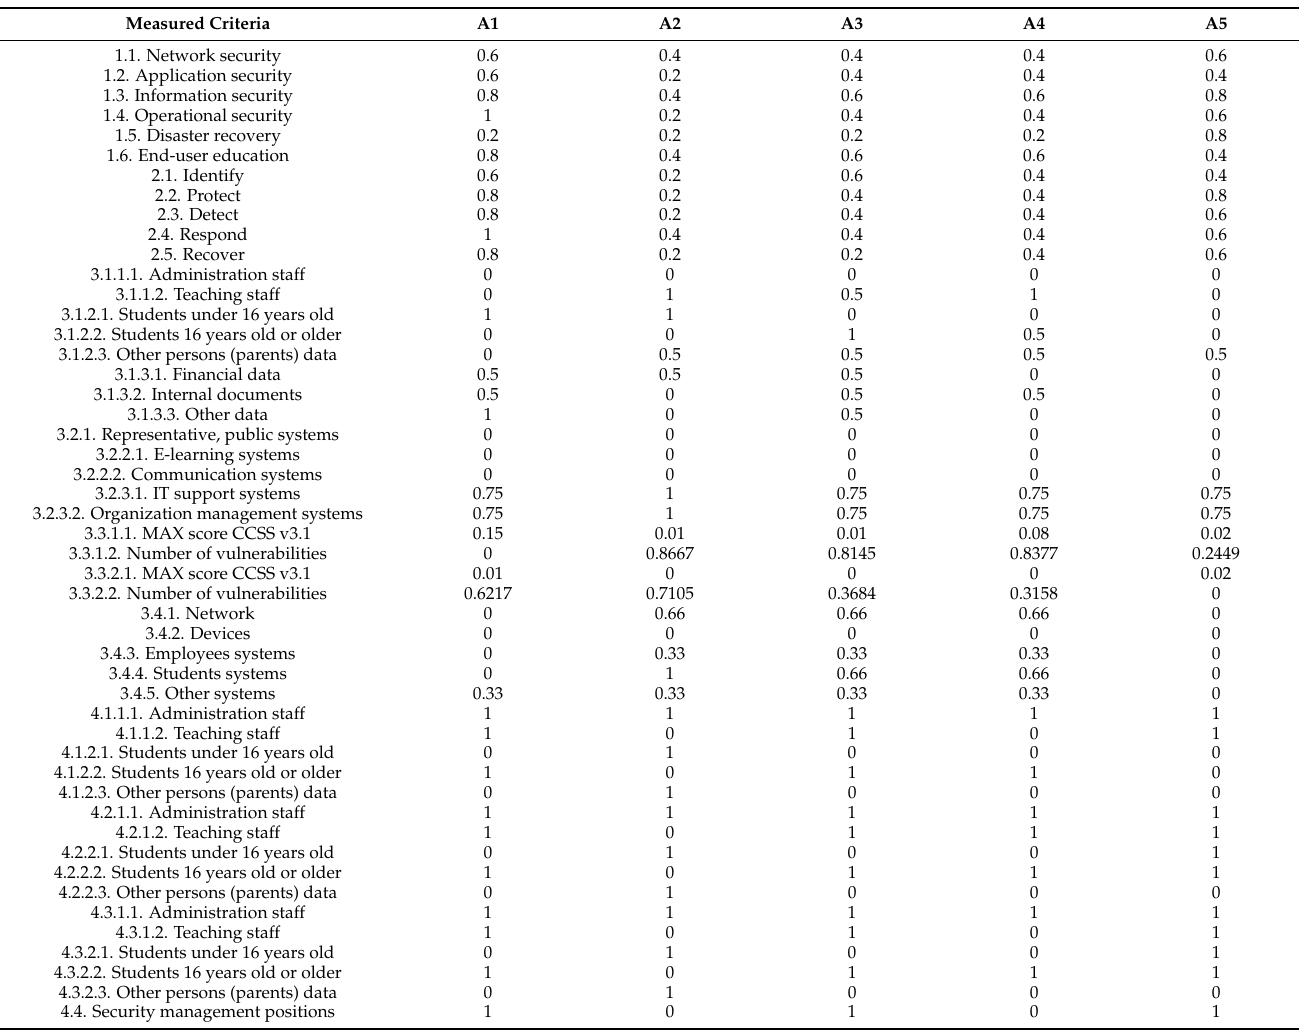
Table A2. Summary of normalized criteria values for all five alternatives. Measured